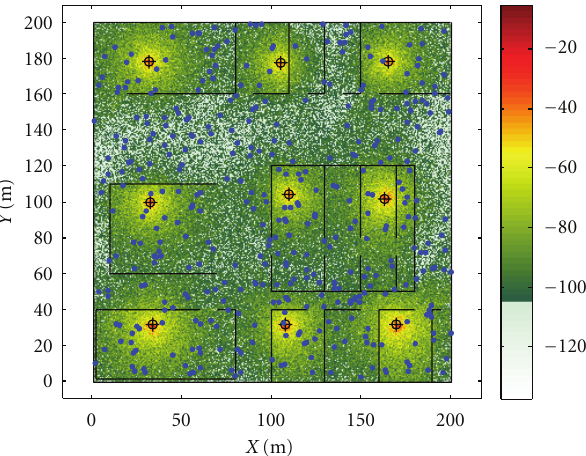
Figure 13: Optimized femtocells coverage when highest weight is given to minimize